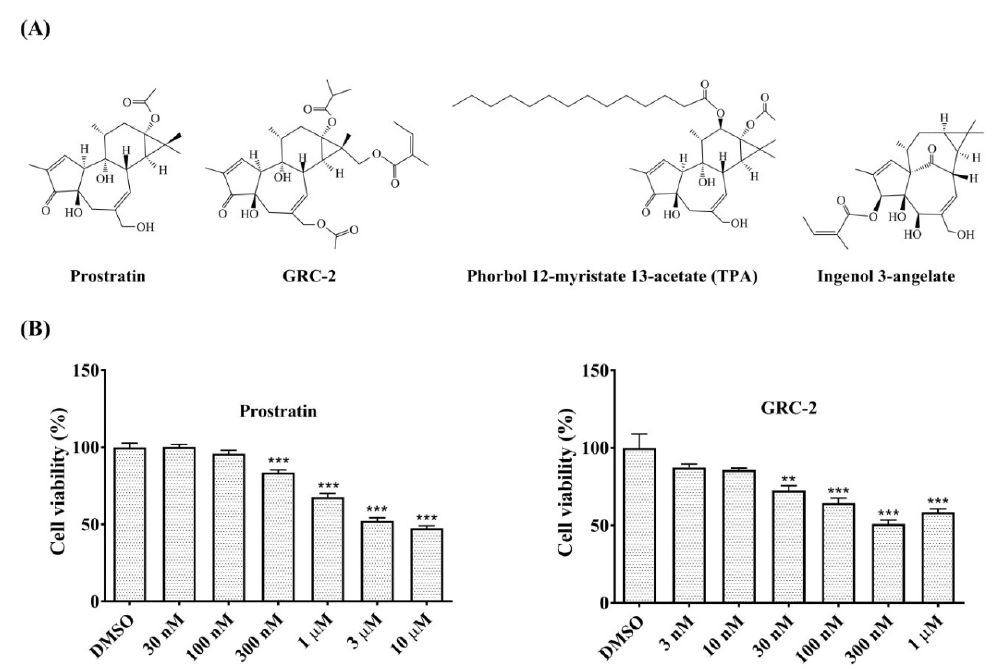
Figure 1. Prostratin and GRC-2 reduce cell viability of human NSCLC A549 cells. ( A ) Chemical structures of prostratin and GRC-2. ( B ) A549 cells were treated with dimethyl sulfoxide (DMSO, vehicle control), prostratin or GRC-2 for 72 h. After then, cell viability was measured by MTT assay. Results are presented as mean ± S.E.M. ( n = 3). ** p < 0.01 and *** p < 0.001 as compared with the vehicle control.